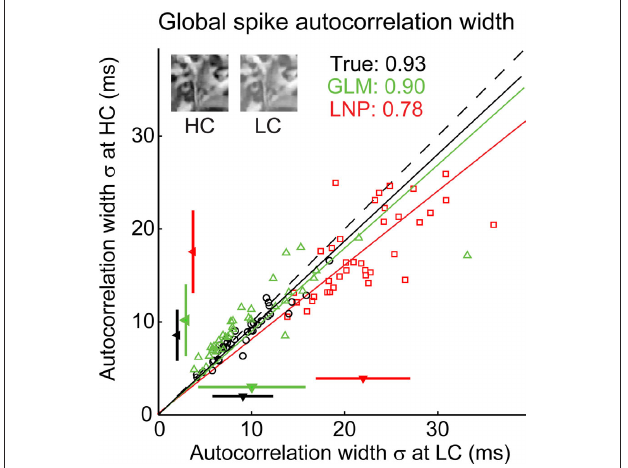
Figure 7 | The gLM predicts the contrast-invariance of timing precision in LgN cells. Temporal precision measured as the global spike autocorrelation width in response to natural scenes at high contrast (HC; 40% RMS contrast) versus low contrast (LC; 15% RMS contrast), for the GLM prediction (green triangles), the LNP model prediction (red squares), and the experimental measurements (black circles). The dashed line has unity slope. For each of the three sets of points, a fitted line of the same color and the corresponding proportionality coefficient are shown, computed between the autocorrelation width measured at HC and that measured at LC using a least-mean-square fit on all data points. The mean ± standard deviation are represented along each axis by an arrowhead and